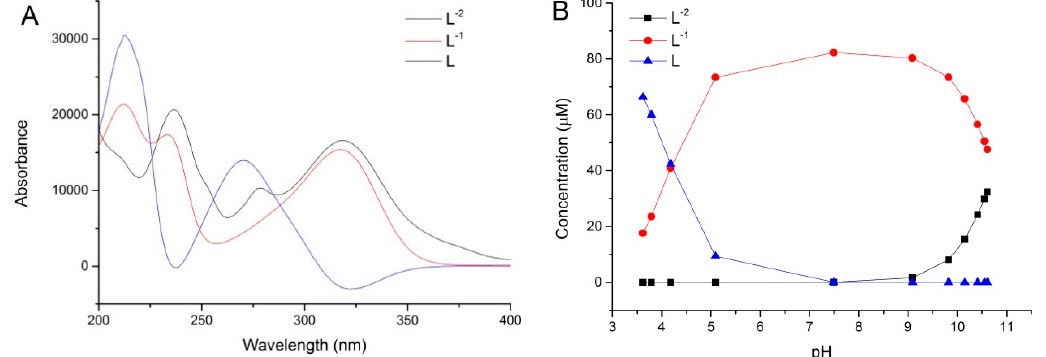
Figure 7. ( A ) The characteristic spectra of MeG and its two deprotonated species (L − 1 , L − 2 ) predicted using chemometric modeling method; ( B ) concentration profiles of protonated MeG (L) and its two deprotonated species predicted by the chemometric method.